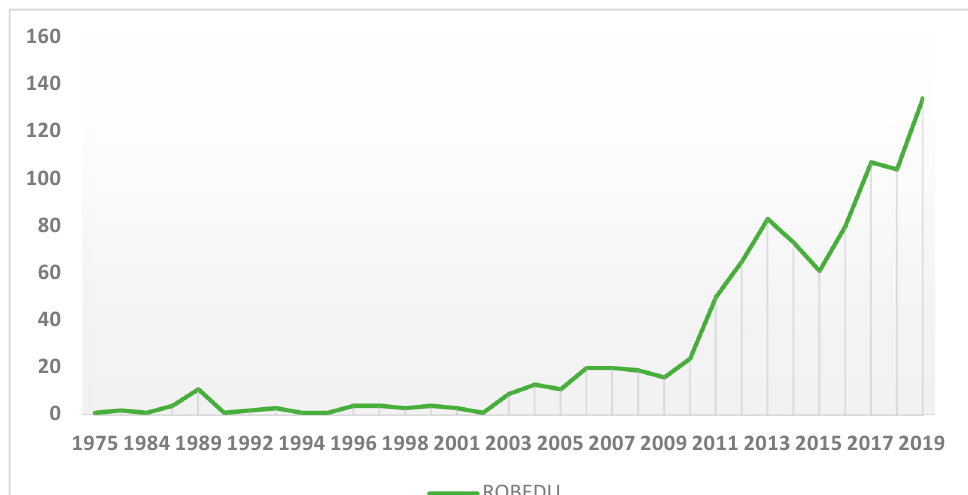
Figure 2. Evolution of scientific production.